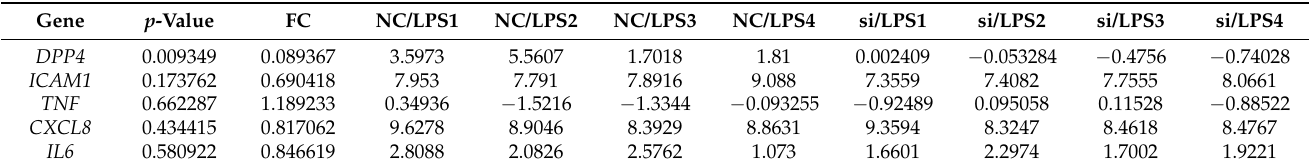
Table 6. Gene expression levels of ARDS-relevant factors after DPP4 siRNA and LPS (NC/LPS vs. DPP4 siRNA/LPS). Normalized gene signals of each sample are shown in the